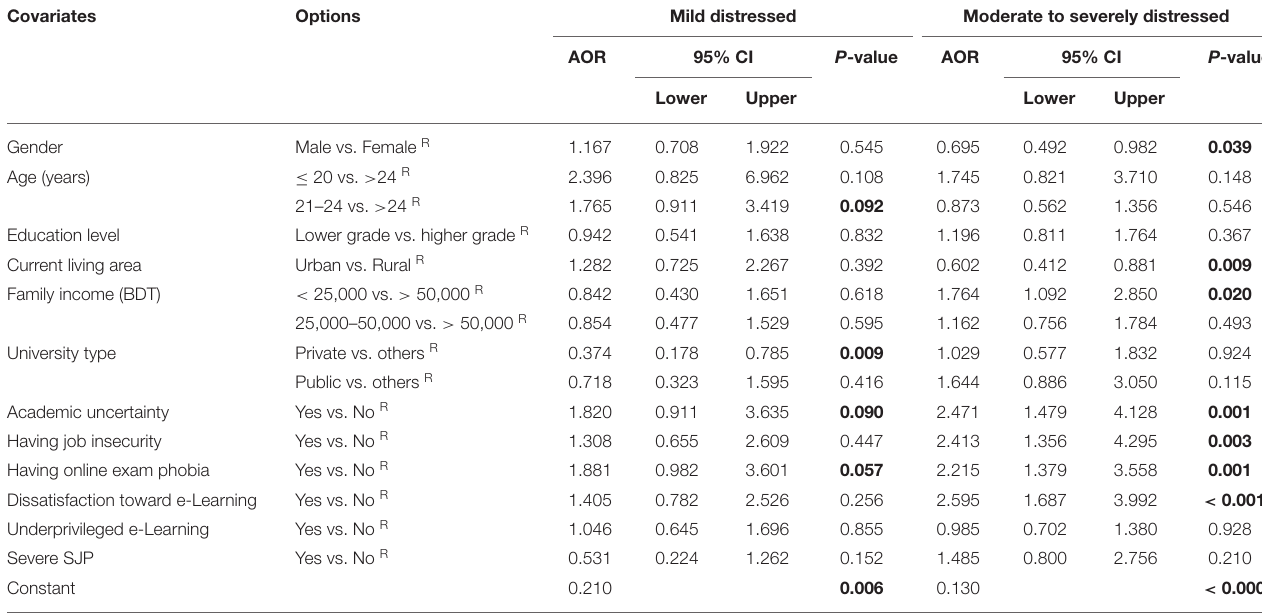
TABLE 4 | Multinomial logistic regression analysis for finding the association of cofactors with several psychological distress conditions among the students following extended closure of university in Bangladesh.